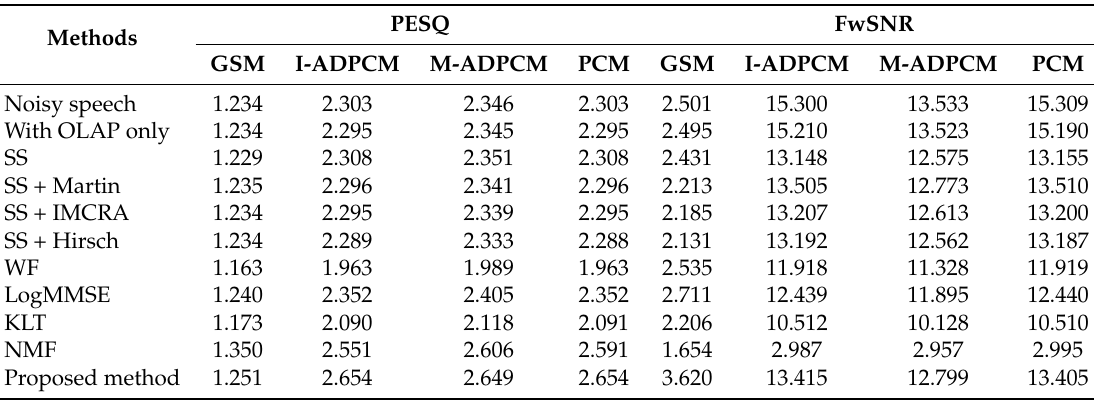
Table 3. Results of our method (PESQ scores and FwSNR) in comparison with other methods. The proposed method applied c = 0.8. OLAP, overlap and add; SS, spectral subtraction; WF, Wiener filter; KLT, Karhurnen–Loeve